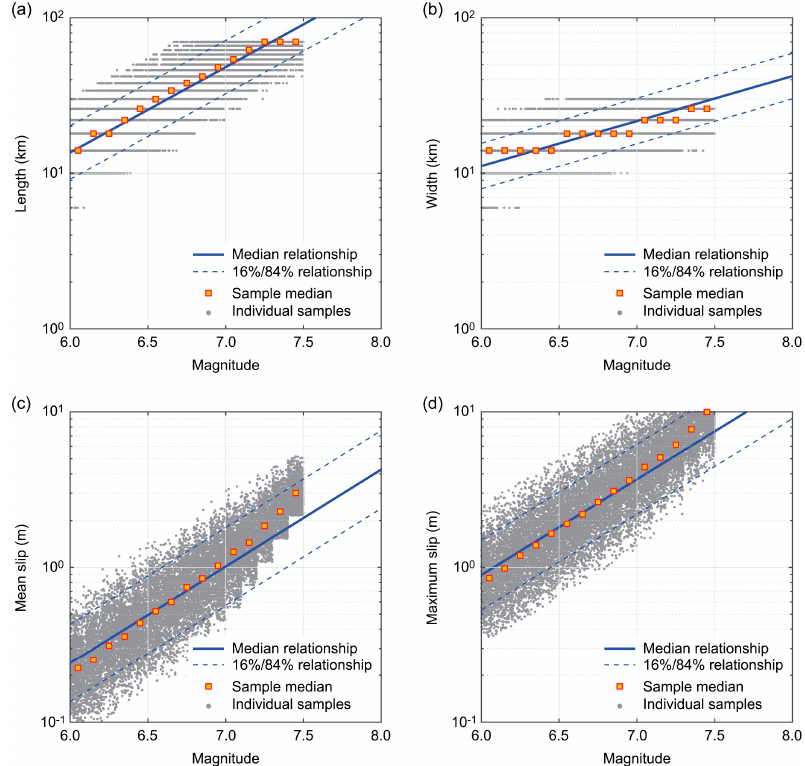
Figure 4. Earthquake scaling relationships and simulated parameters for the stochastic earthquake source models for the fault length ( a ), fault width ( b ), mean slip ( c ), and maximum slip ( d ).